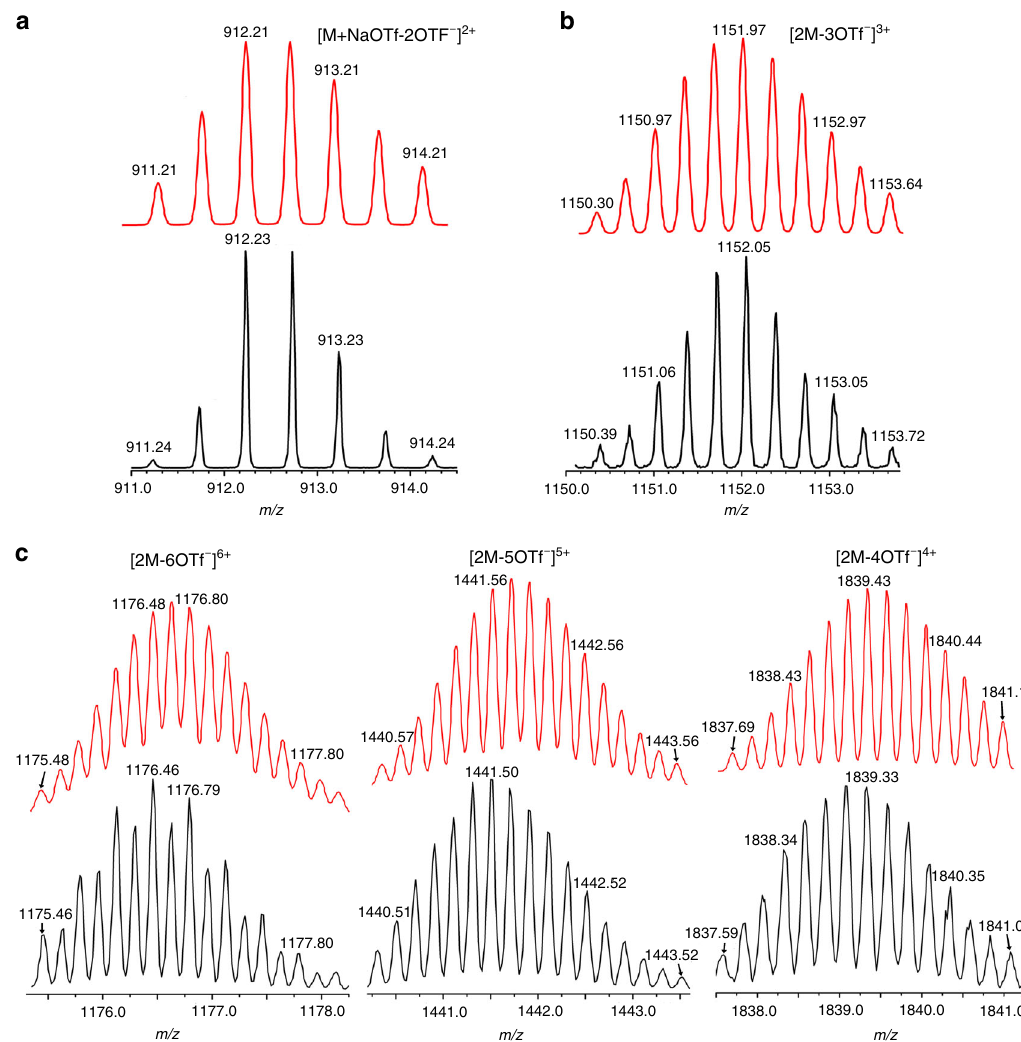
Fig. 3 ESI-TOF-MS spectra of NaOTf ⊂ 6, 6/7 and 9/10. a Experimental (black) and calculated (red) ESI-TOF-MS spectra of NaOTf ⊂ 6 ([M + NaOTf- 2OTf − ] 2 + ). b Experimental (black) and calculated (red) ESI-TOF-MS spectra of 7 ([2M-3OTf − ] 3 + ). c Experimental (black) and calculated (red) ESI-TOF- MS spectra of 10 . For full spectra, see Supplementary Figs. 16, 21 and